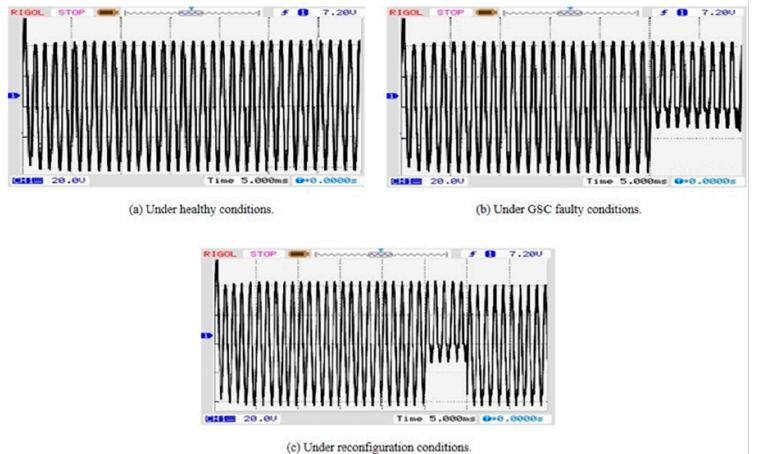
Figure 12. 5-Level output current under healthy, GSC faulty and reconfiguration conditions.